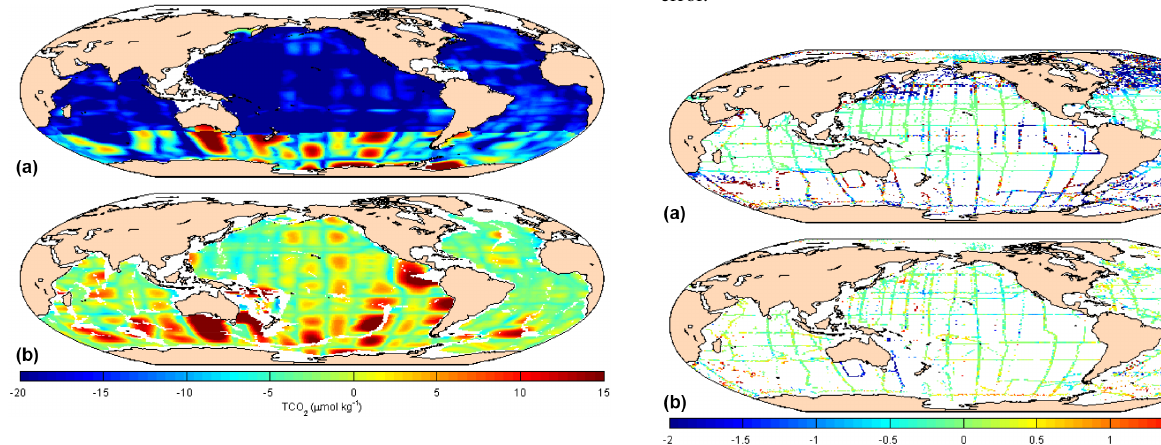
Figure 12. Mapping error for TCO 2 in GLODAPv2.2016b mi- nus mapping error for TCO 2 in GLODAPv1.1 at 10m (a) and 3000m (b) . Note that the differences are mainly attributable to dif- ferences in method and not real reductions/increases in mapping error.